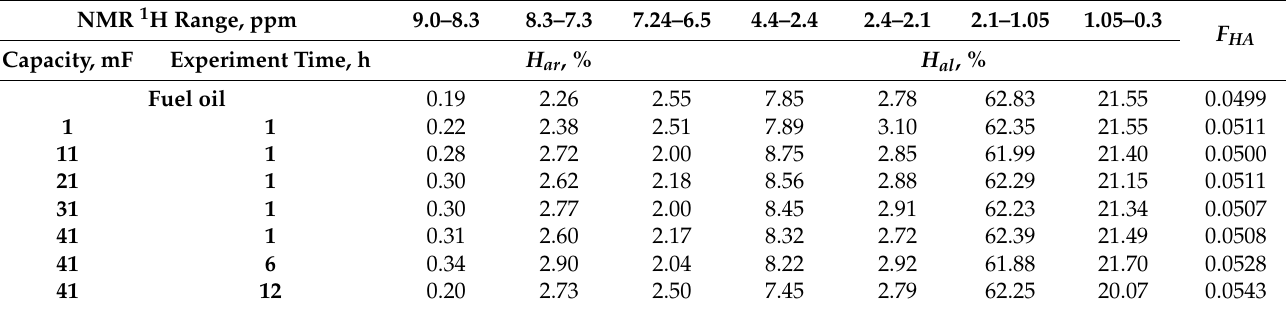
Figure 3. Fractional composition of fuel oil (1) and NTP products—fuel oil pyrolysis at experimental times of 1 h (2), 6 h (3), 12 h (4). Table 4. 1 H NMR analysis of fuel oil and NTP pyrolysis